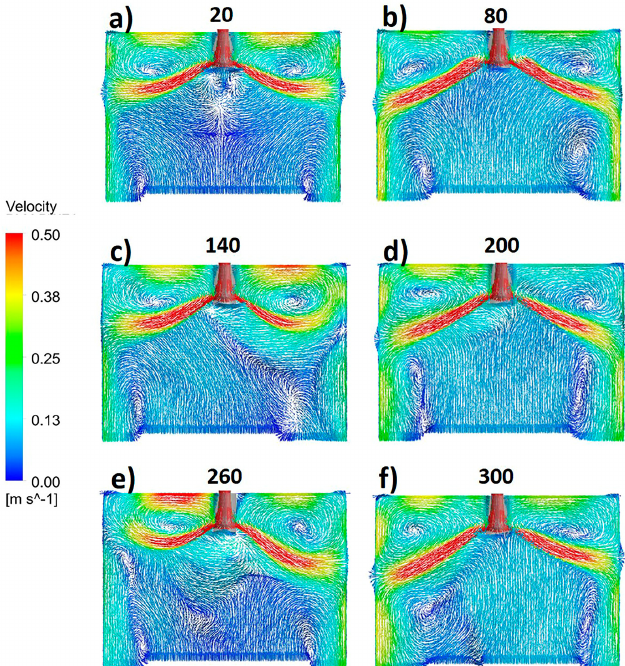
Figure 5. Numerical velocity fields in the central plane of the mold at different times (( a ) 20 s; ( b ) 80 s; ( c ) 140 s; ( d ) 200 s; ( e ) 260 s; ( f ) 300 s) are indicated in each image. ( c ) 140 s; ( d ) 200 s; ( e ) 260 s; ( f ) 300 s) are indicated in each